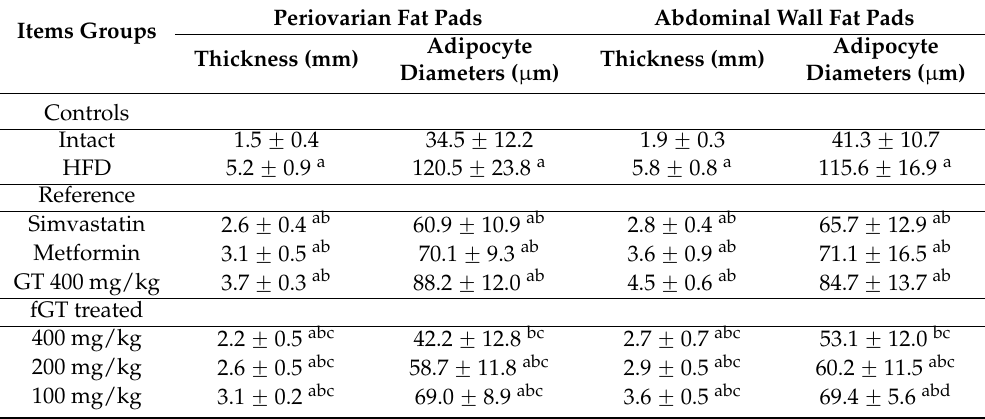
Table 4. Changes in the histopathology-histomorphometry of the periovarian and abdominal wall deposited fat pads in NFD or HFD supplied